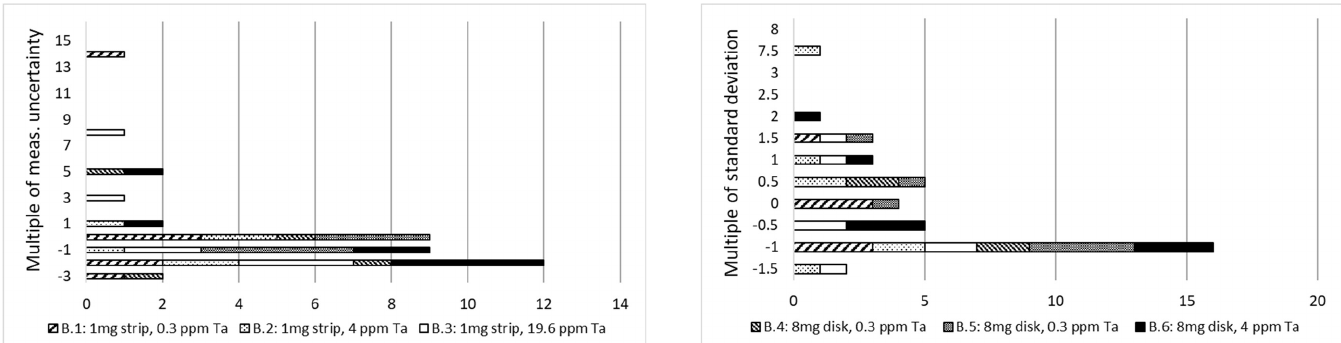
Fig. 7 Distributions of discrepancies from mean relative to measurement uncertainties, σ meas (on left) and relative to standard deviation, σ pop (on right). The legend applies to both graphs.